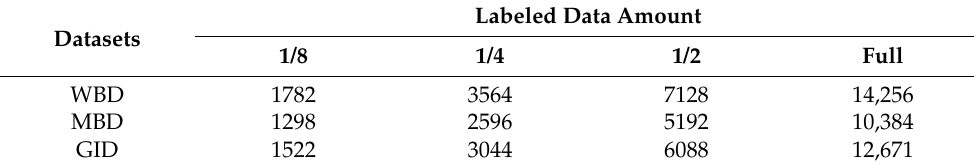
Table 1. Amounts of labeled data.